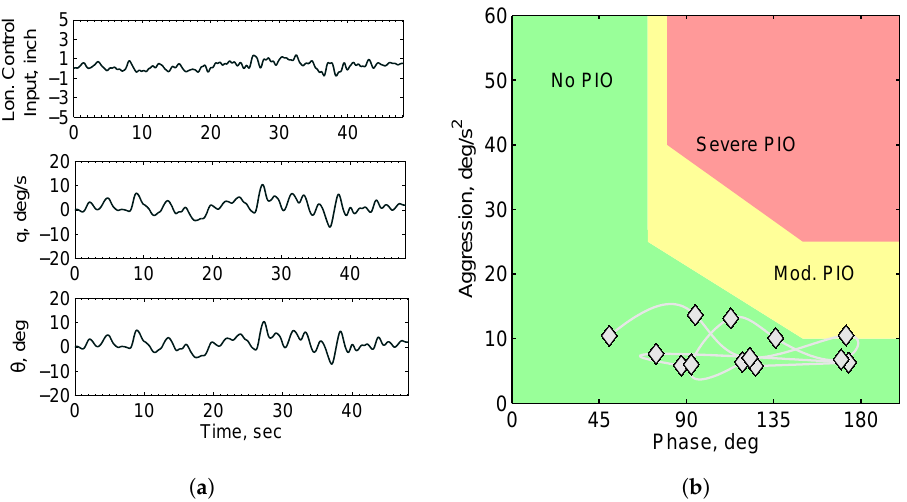
Figure 17. Results from Depart–Abort, longitudinal, Case 73 APC = 2. ( a ) Time recording-Case 73; ( b ) PAC results for Case